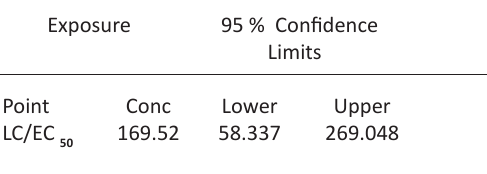
analysis of secondary 50